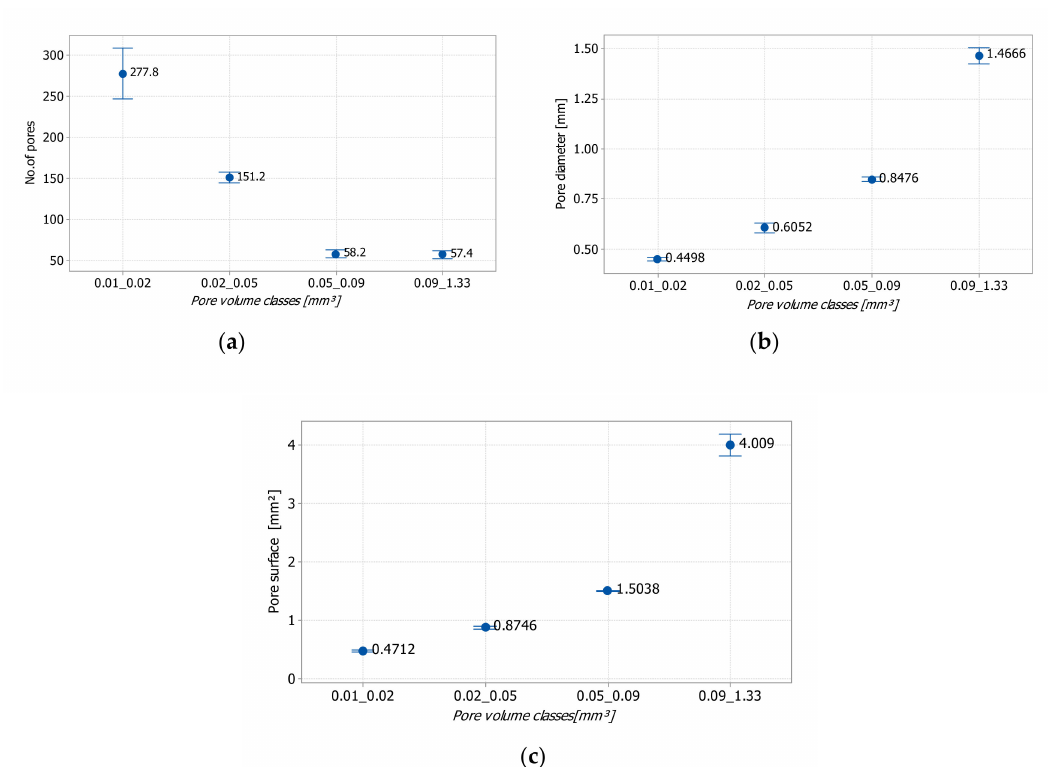
Figure 15. Panel 1: the intervals plot of ( a ) the number of pores, ( b ) pore diameters, ( c ) and the surfaces of the pores versus pore volume classes. Bars are one standard error from the